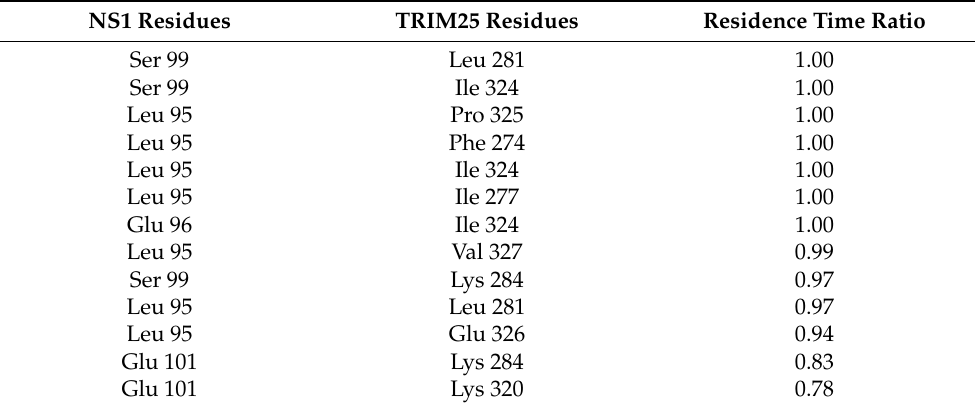
Table 5. Stable pairwise residue–residue interactions at the interface of the complex between NS1 and TRIM25 chain